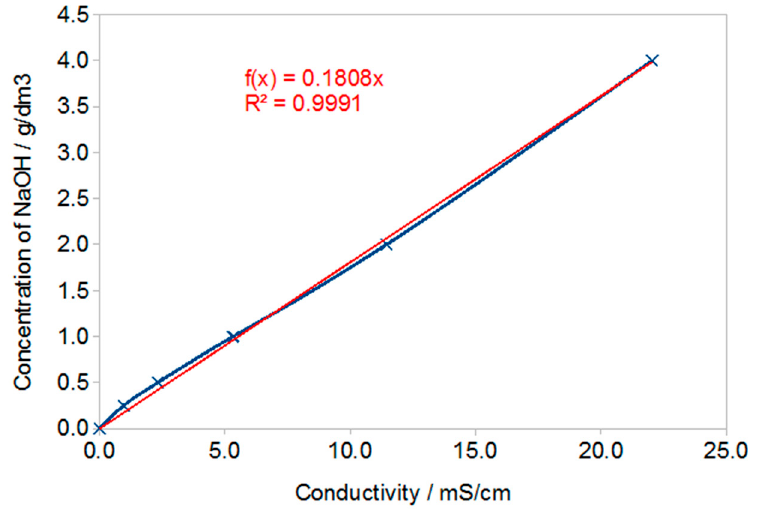
Figure 4. Dependence on NaOH concentration.